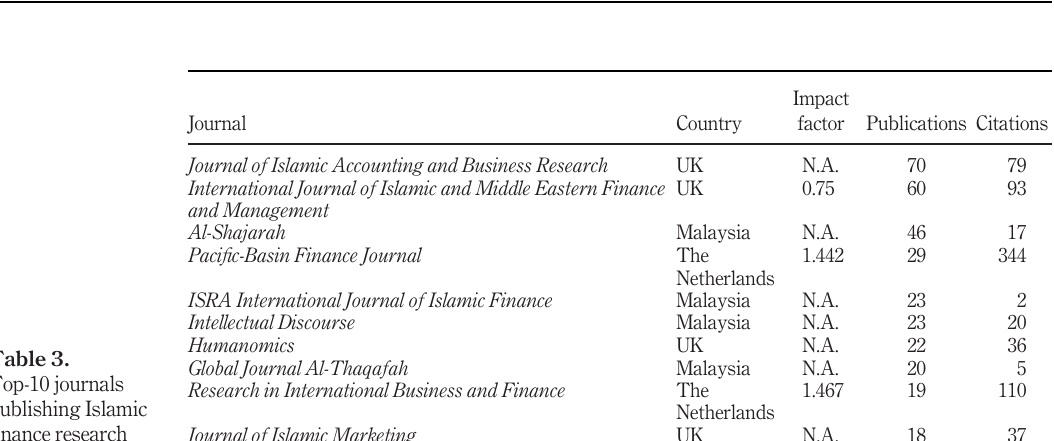
publishing Islamic fi nance research